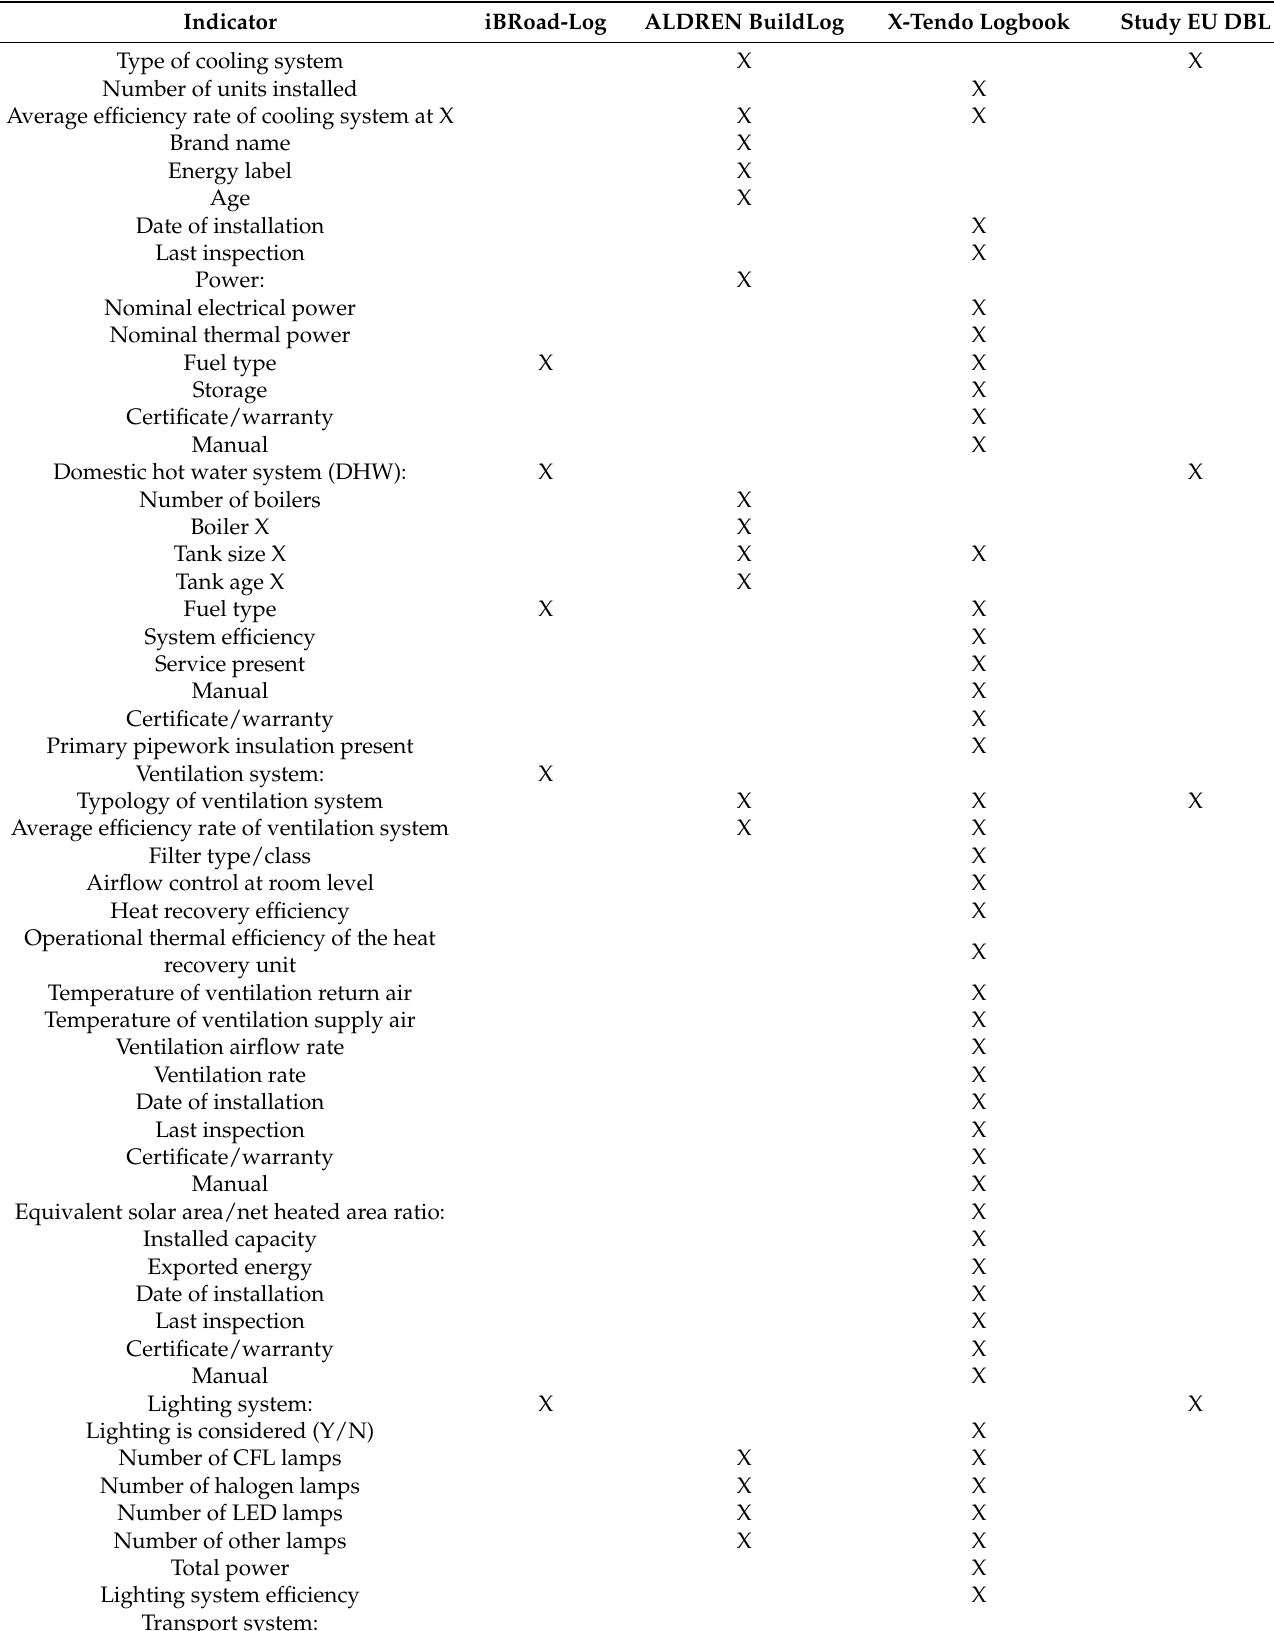
Table A3. Cont. iBRoad-Log ALDREN BuildLog X-Tendo Logbook Study EU